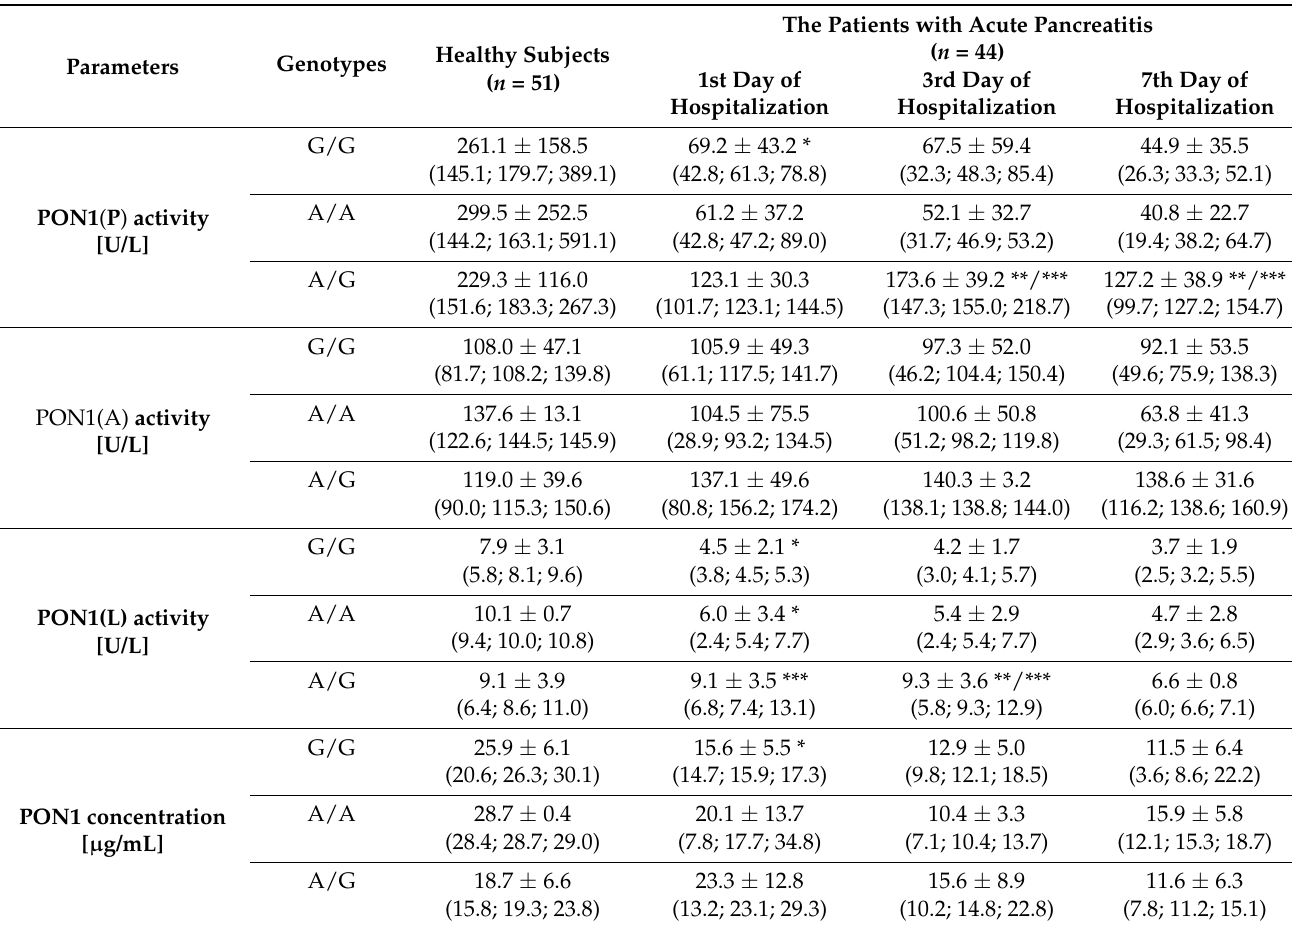
Table 5. PON1 activities, its concentration, the concentration of apoA-I, lipid profile, and selected markers of pro/antioxidative balance in the context of genotypic variability of SNP − 75 bp in the APOA1 gene in the group of healthy subjects and AP